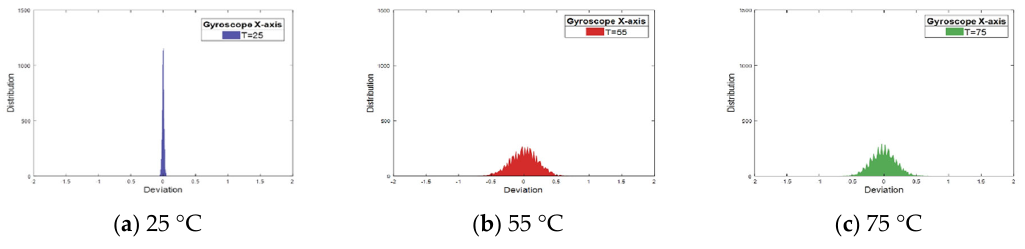
Figure 12. Noise distribution chart of the X ‐ axis of the gyroscope sensor.